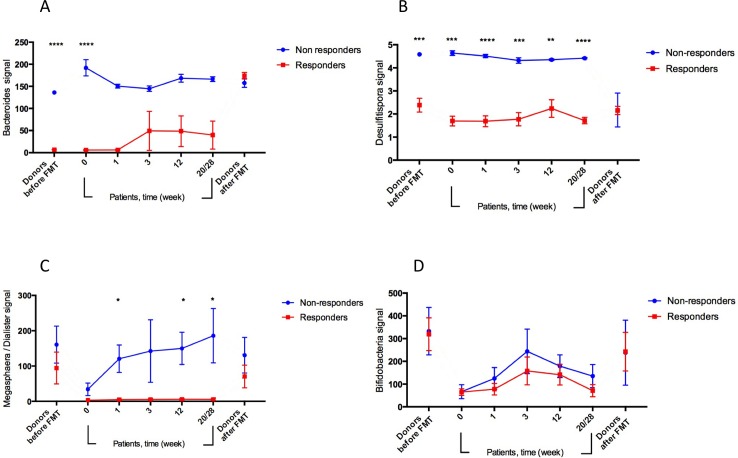
The characteristic differences of gut microbiota between responders and non-responders groups before and after FMT.The bacterial signals of (A) Bacteroides, (B) Desulfitispora, (C) Megasphaera/Dialister and (D) Bifidobacteria, in the responders and non-responders groups between the donors at the beginning of the study (before FMT), and between the patients in weeks 0, 1, 3, 12 and 20/28.